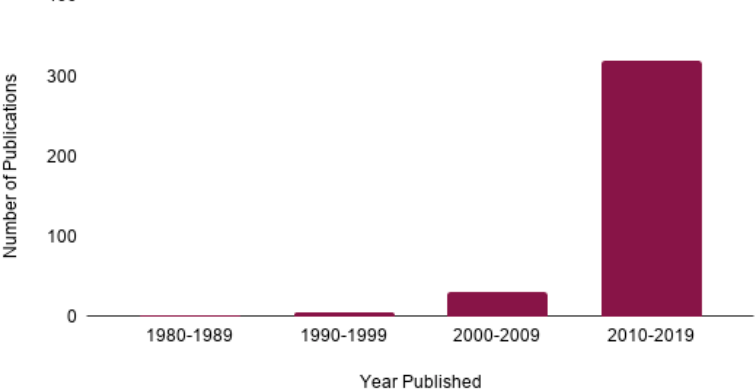
Figure 1. PubMed publication search for Autism and Sensory modalities. Publications by decade for Autism Spectrum Disorder and sensory processing from 1980 through 2019.